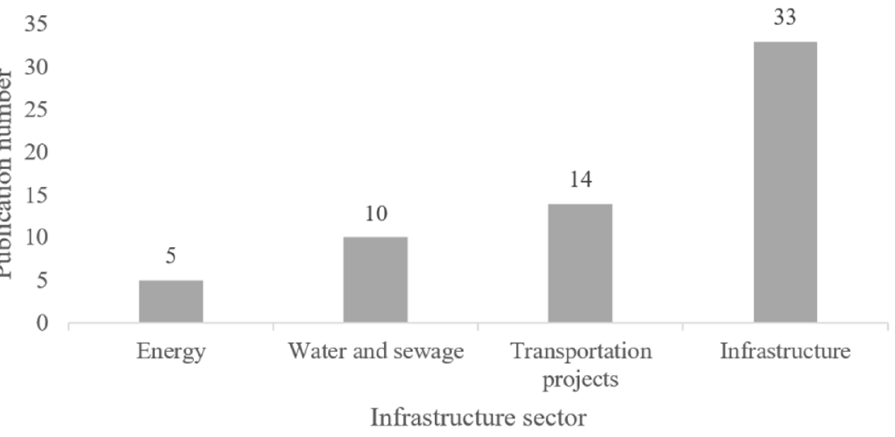
Figure 5. The distribution of publications by infrastructure sectors.